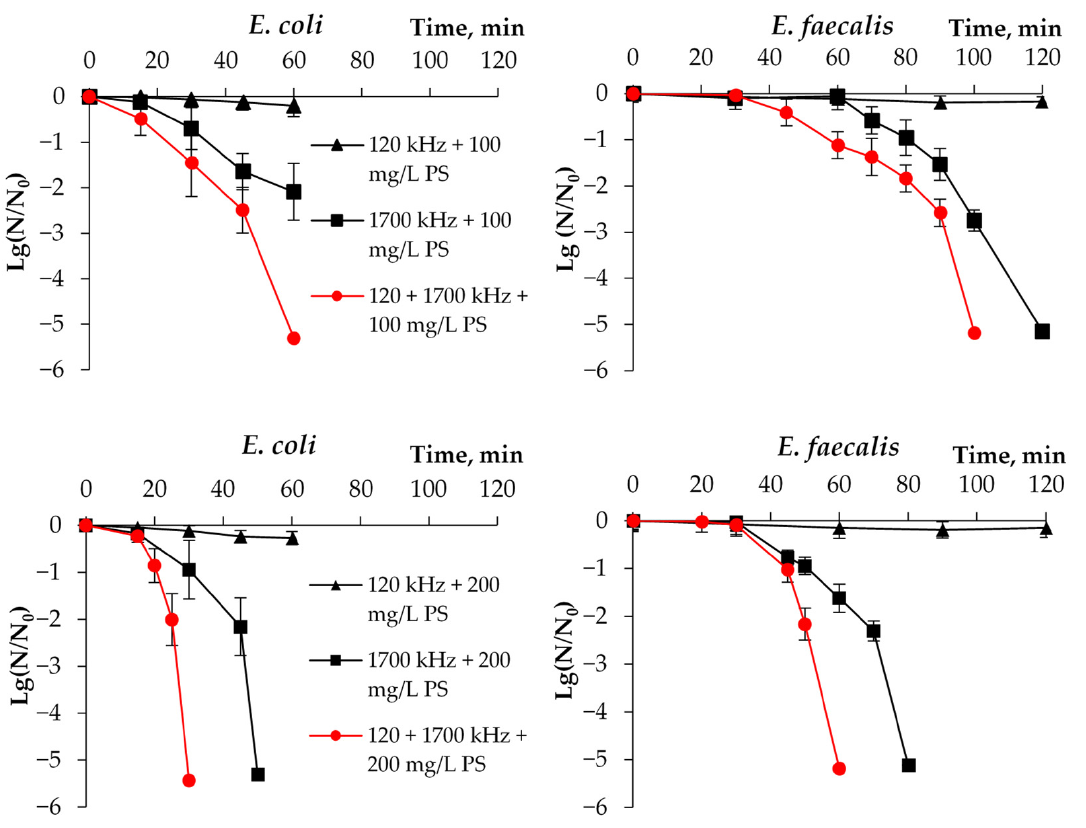
Figure 3. Inactivation of E. coli and E. faecalis by single- and dual-frequency ultrasound in the presence of persulfate (PS). Error bars represent ±SD.